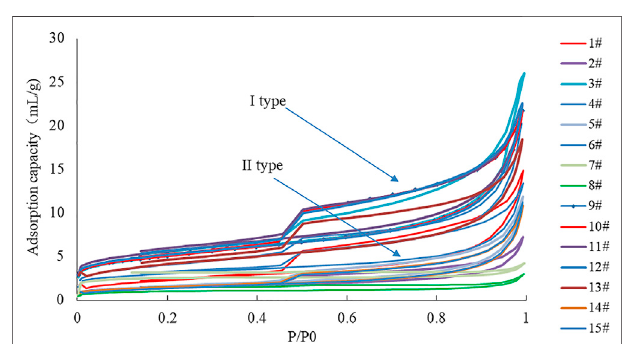
FIGURE 6 | Liquid nitrogen adsorption and desorption curves of different